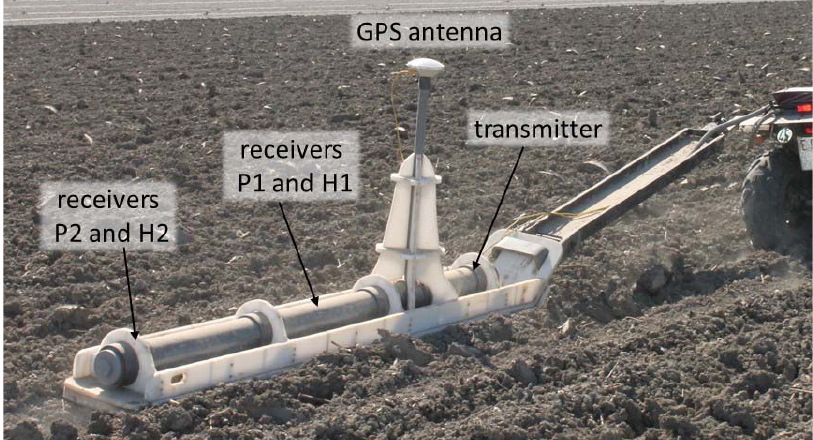
Figure 2. PVC sled used to measure apparent electrical conductivity with a DUALEM-21S electromagnetic induction sensor, with the positions of the GPS antenna, the transmitter and the four receiver coils indicated.